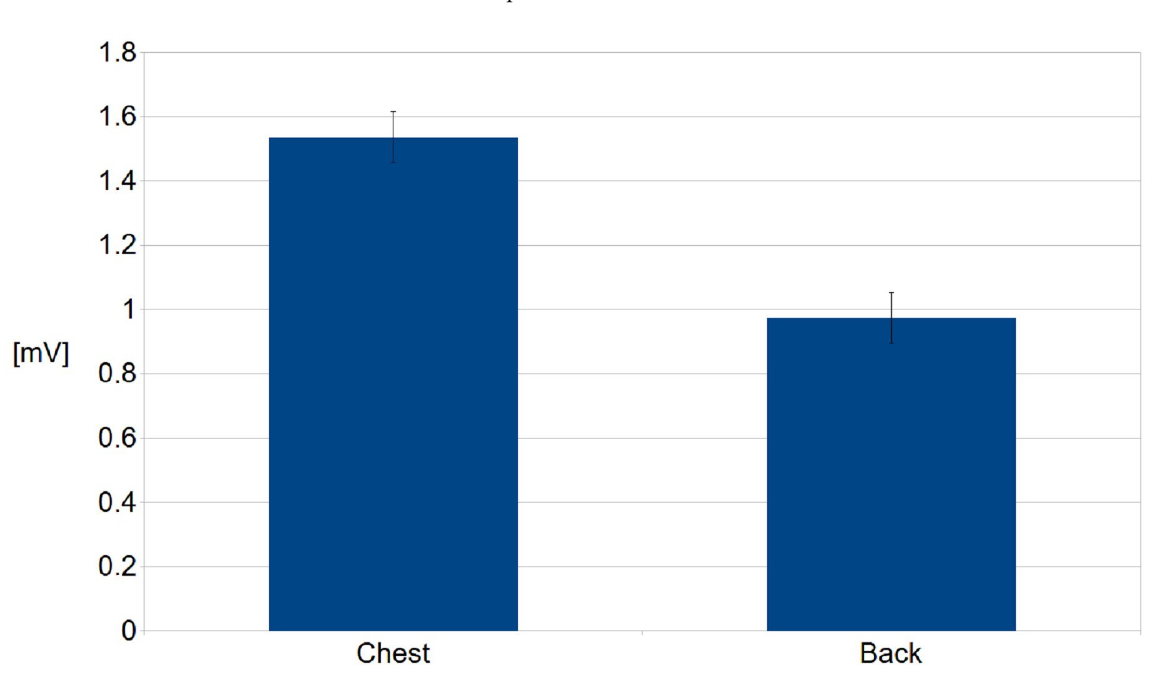
Figure 7. Simultaneous recording of ECG and cECG using different leads presented in Figure 5; electrical axis was almost parallel to the I Eindhoven lead.